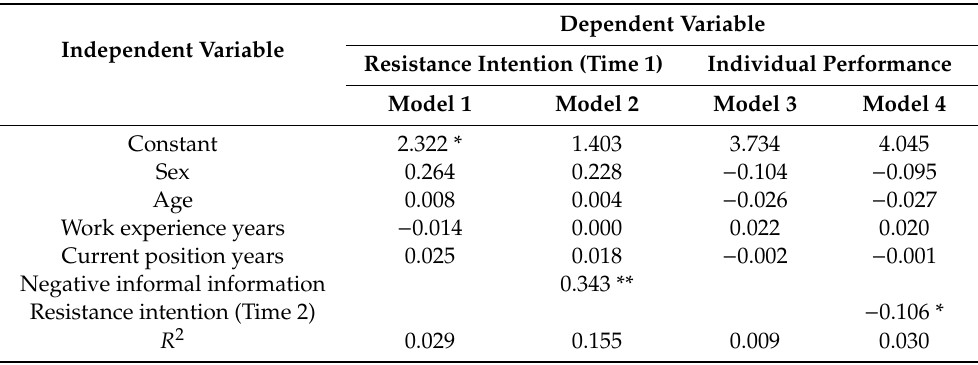
Table 3. Regression analysis results.